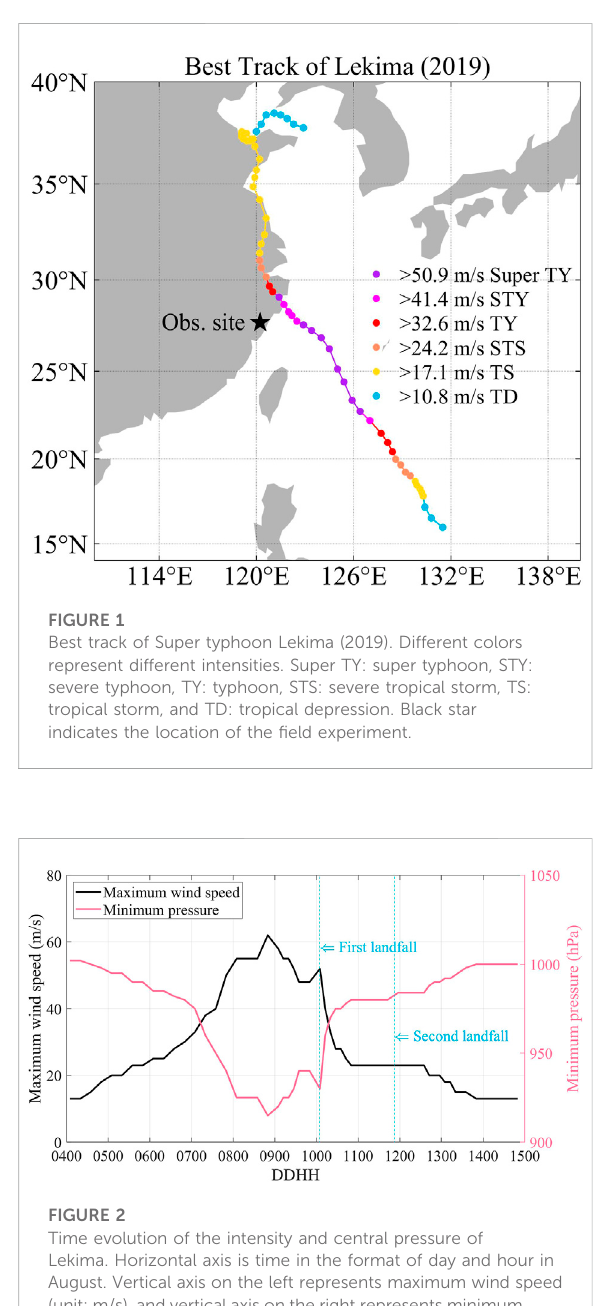
Time evolution of the intensity and central pressure of Lekima. Horizontal axis is time in the format of day and hour in August. Vertical axis on the left represents maximum wind speed (unit: m/s), and vertical axis on the right represents minimum pressure (unit: